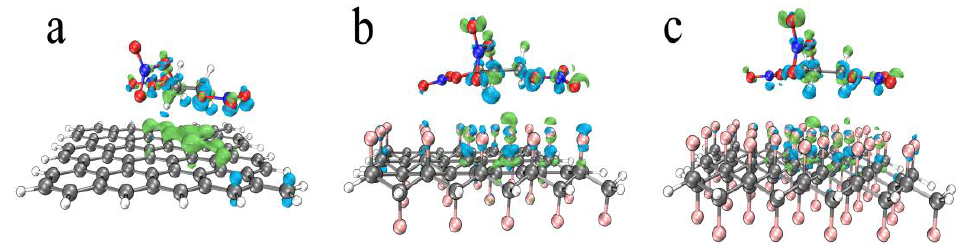
Figure 12. The electron density difference maps. ( a ) Graphene. ( b ) Half-fluorinated graphene. ( c ) Whole-fluorinated graphene.